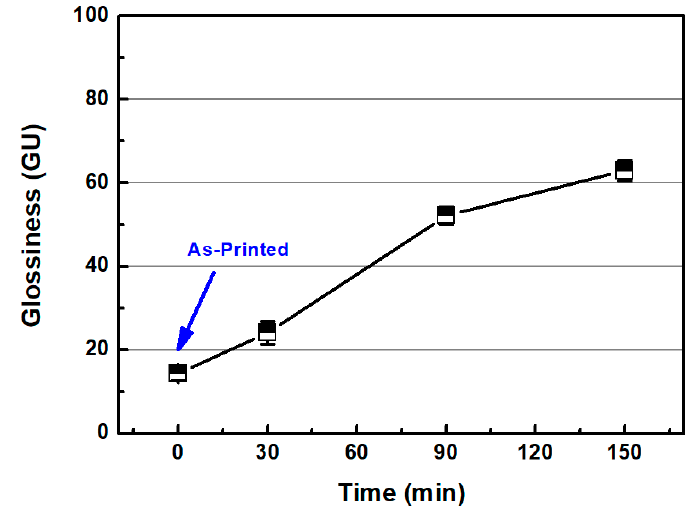
Figure 6. Glossiness as a function of CMP processing time with one-step polishing method.